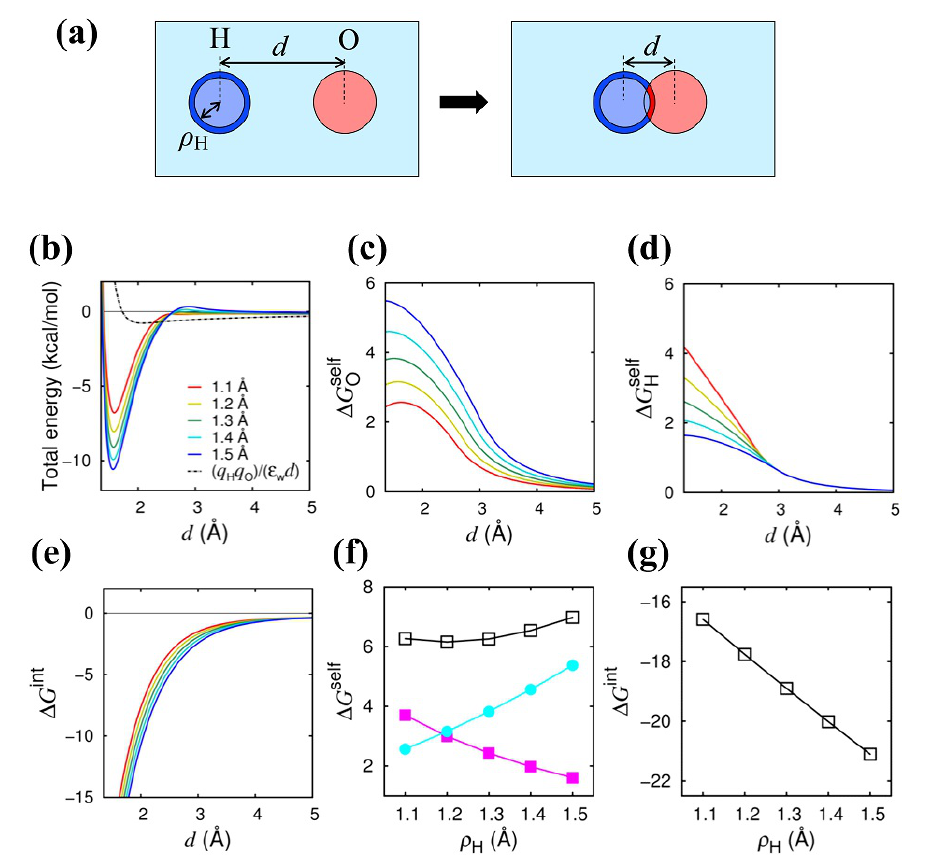
Figure 1. Effect Author request: Please enlarge the figure size for visibility (we changed the ration from 0.8 to 0.95 of ρ H on Coulomb energies in H–O system. ( a ) Illustration of the Coulomb bond formation. Dark-colored regions indicate the regions that are subjected to the integral in Equation (11) and are affected by the increase in ρ H . ( b ) Total energy [i.e., the sum of the Coulomb and van der Waals (Lennard–Jones) energies] is shown as a function of the separation distance d between the two atoms at different ρ H values (1.1 to 1.5 Å). The dotted line represents the total energy where Equation (3) is used for the Coulomb energy ( ε w = 78.5). ( c ) Desolvation ∆ G self , ( d ) desolvation O energy ∆ G self , and ( e ) interaction energy G int are shown as a function of d . Line colors correspond H + ∆ G self to those in ( b ). ( f ) Desolvation energies [ ∆ G self (cyan), ∆ G self (magenta), and ∆ G self (open H H O O square)] at d = 1.57 Å are shown as a function of ρ H . ( g ) Interaction energy G int at d = 1.57 Å is shown as a function of ρ H . Energy unit is